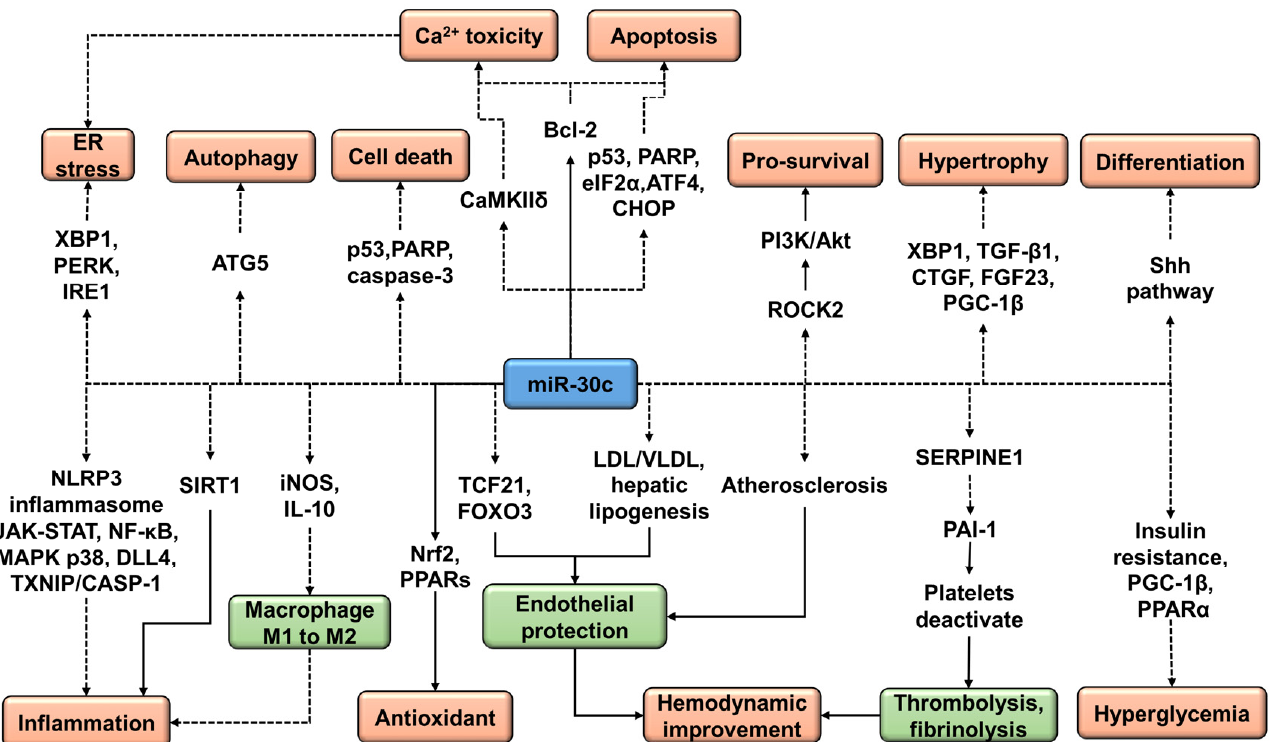
Figure 5. Role of miR-30c in different cell functions and signaling pathways implicated in neurological disorders. A solid arrow represents activation and a dashed arrow represents inhibition.